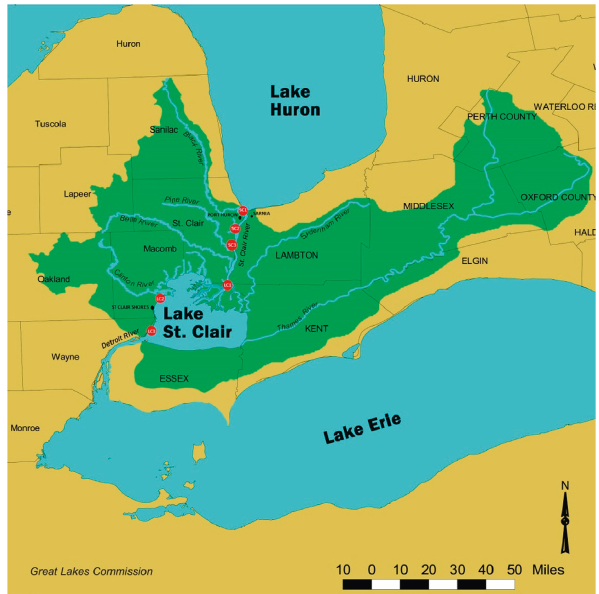
Figure 1: Sediment sample location map for the 2016 sampling. This map shows the Saint Clair River, Lake Saint Clair, and sur- rounding rivers and cities. The red circles represent the sites where the samples were taken